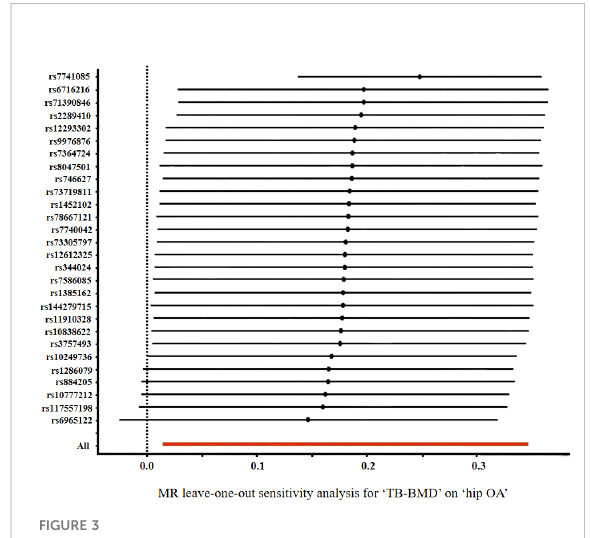
FIGURE 3 Forrest plot of the causal effects of TB-BMD-associated single nucleotide polymorphisms (SNPs) on hip